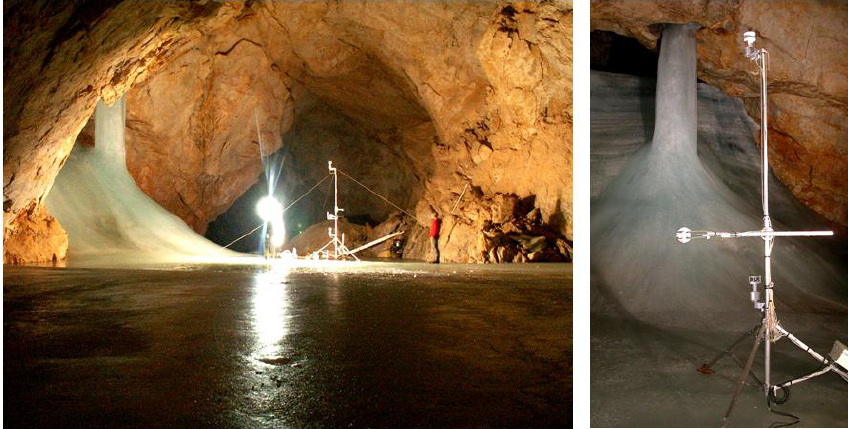
Fig. 1. View on the Eispalast measurement site (left) and on the meteorological instruments